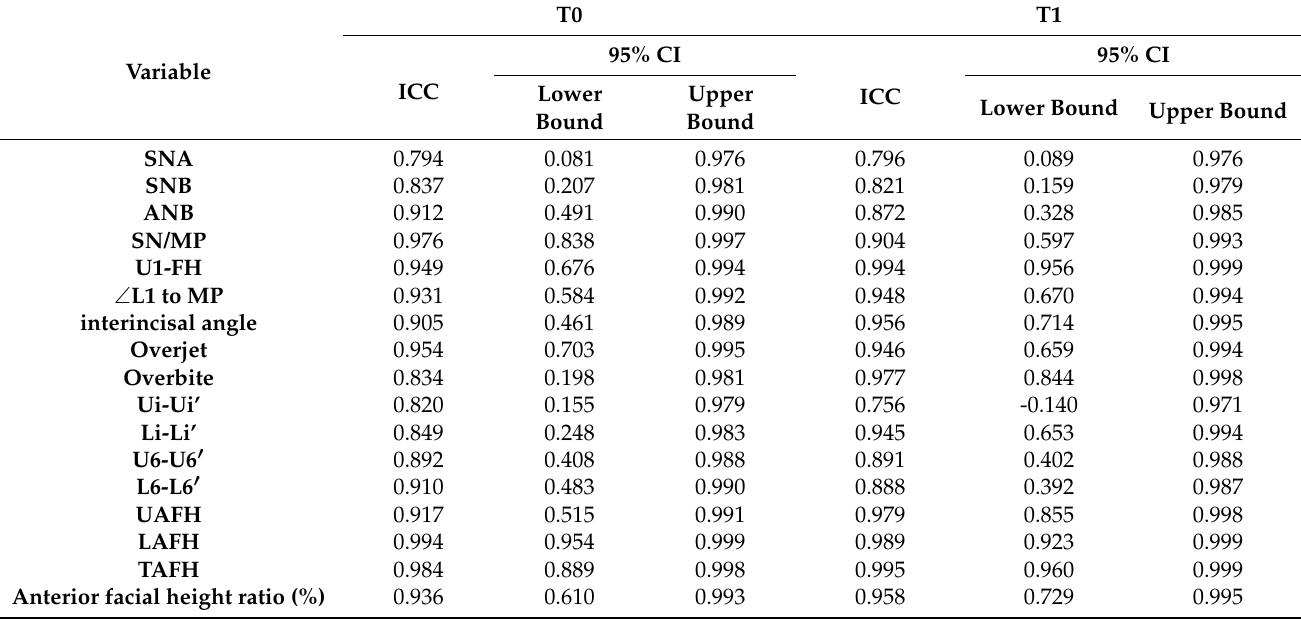
Table 2. The intra-examiner ICCs for each